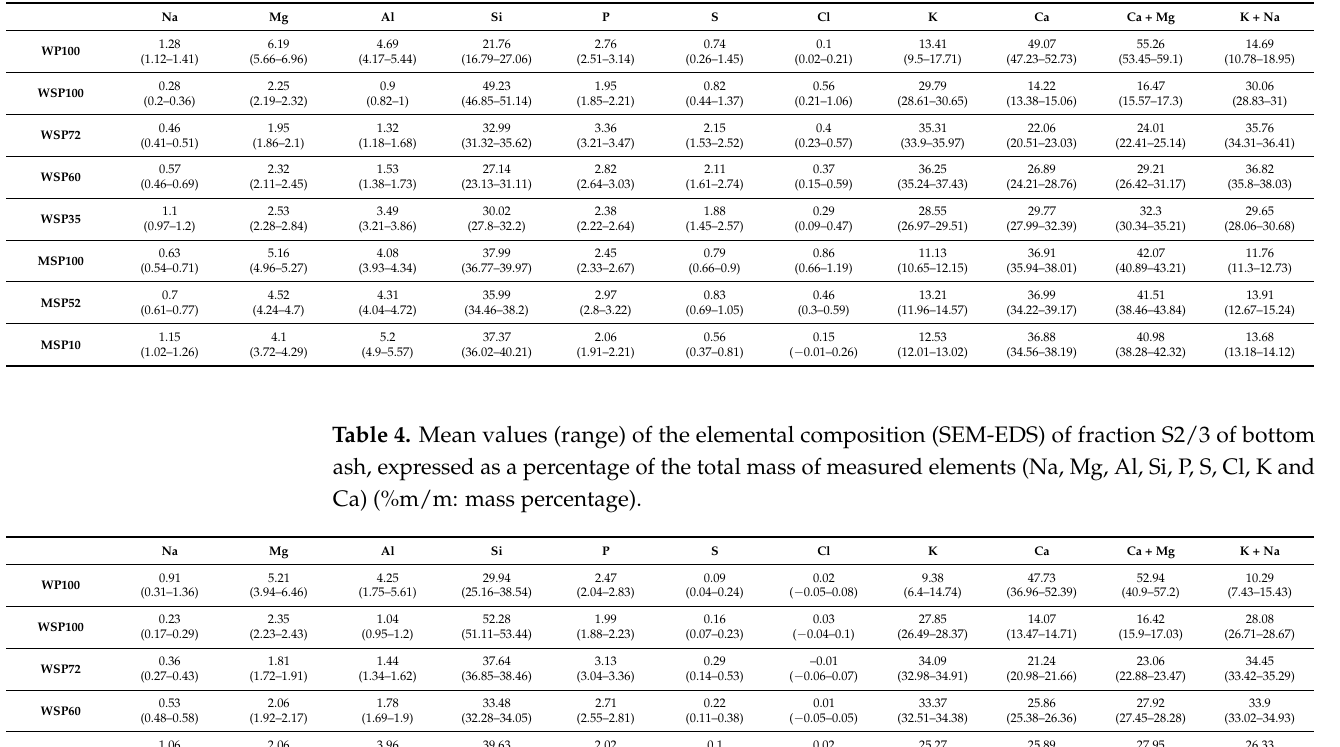
Table 3. Mean values (range) of the elemental composition (SEM-EDS) of fraction S1 of bottom ash expressed as a percentage of the total mass of measured elements (Na, Mg, Al, Si, P, S, Cl, K and Ca) (%m/m: mass percentage).